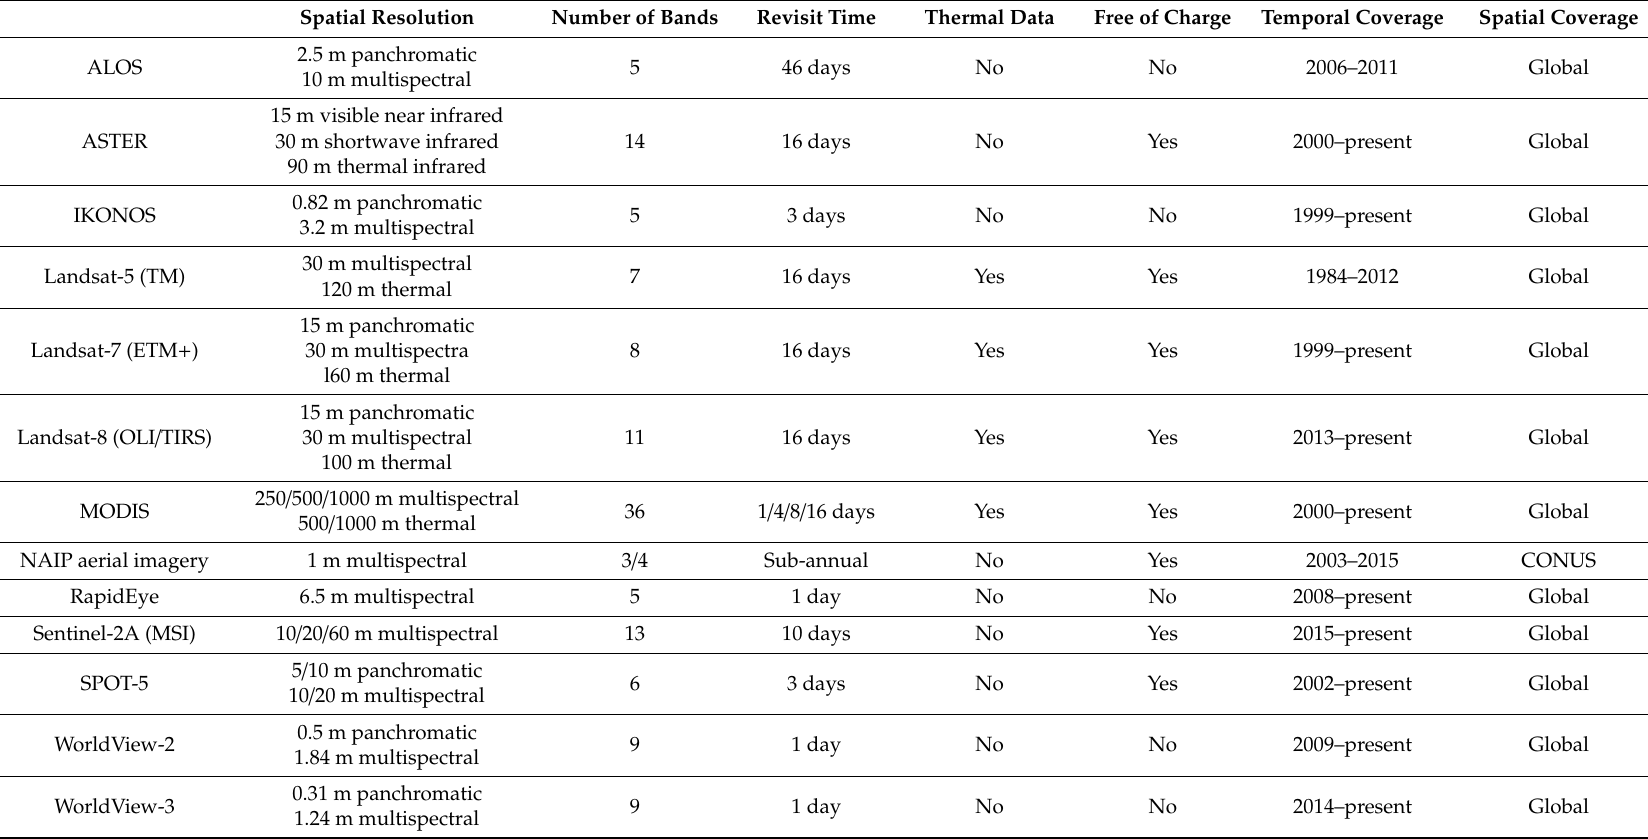
Table 3. Description of commonly used remote sensing products / platforms for urban forest